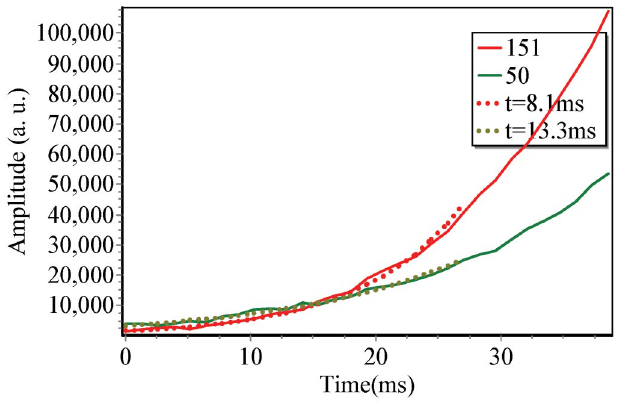
FIG. 14. (Color) Growth of lower and higher modes with the (cid:1) 60% case on the horizontal L sol